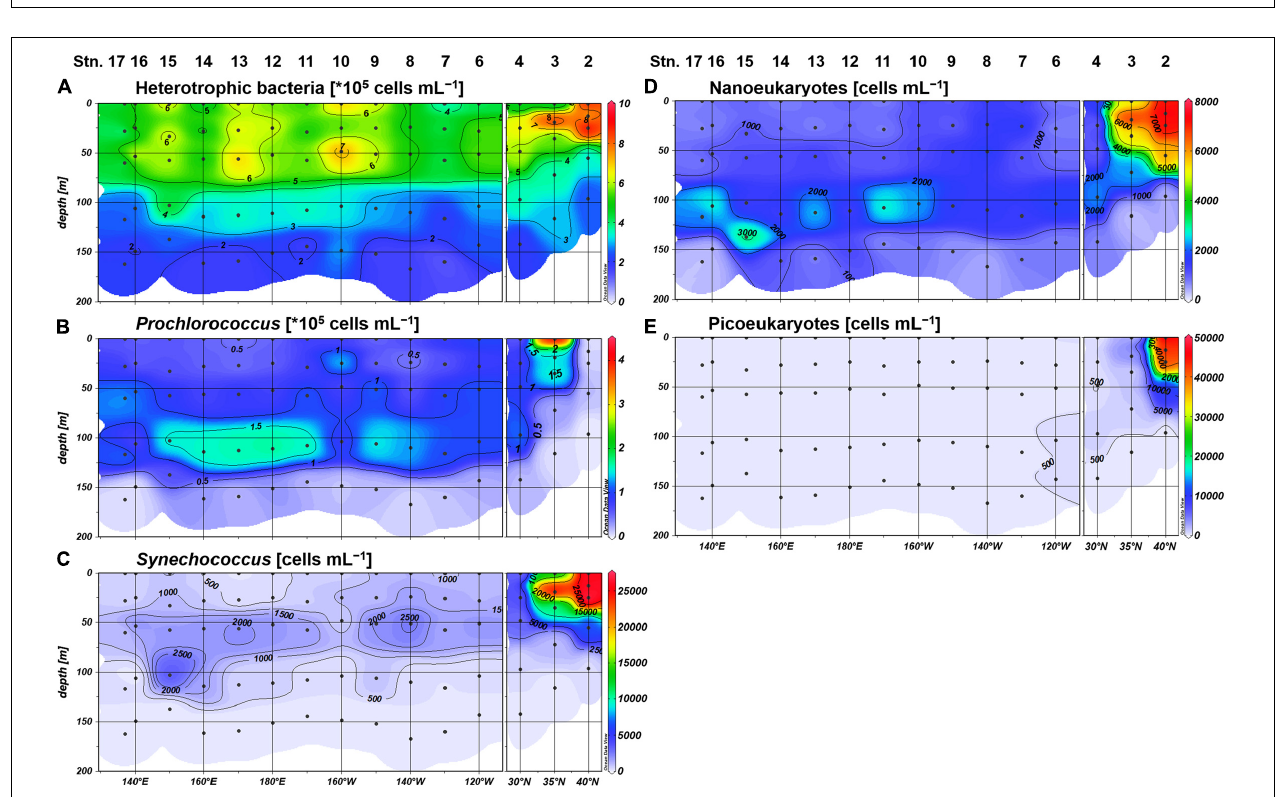
They were significantly negatively correlated with depth at each station, and these vertical profiles were opposite to those of other inorganic nutrients ( Figure 2 ). In contrast, significant positive correlations were observed at Stations